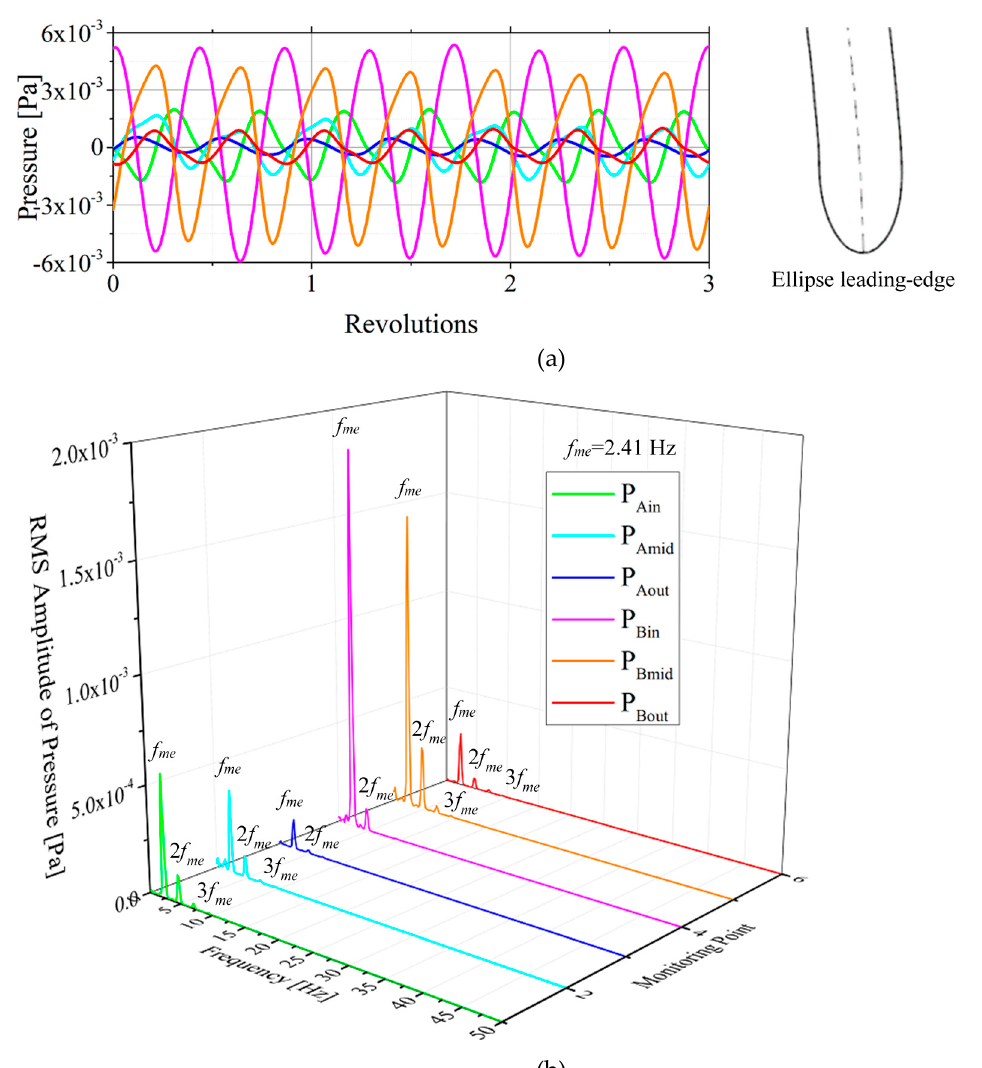
Figure 17. Pressure pulsation in the ellipse leading-edge impeller: ( a ) time-domain plot (three revolutions); ( b ) frequency-domain plot, monitor points (1) P Ain , (2) P Amid , (3) P Aout , (4) P Bin , (5) P Bmid , and (6) P Bout.